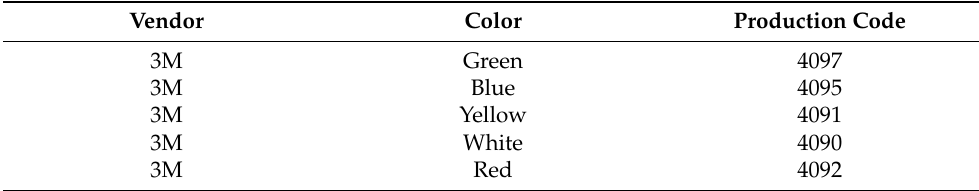
Table 1. Colors of the retroreflective foils of the vendor 3M and the corresponding production codes. Vendor